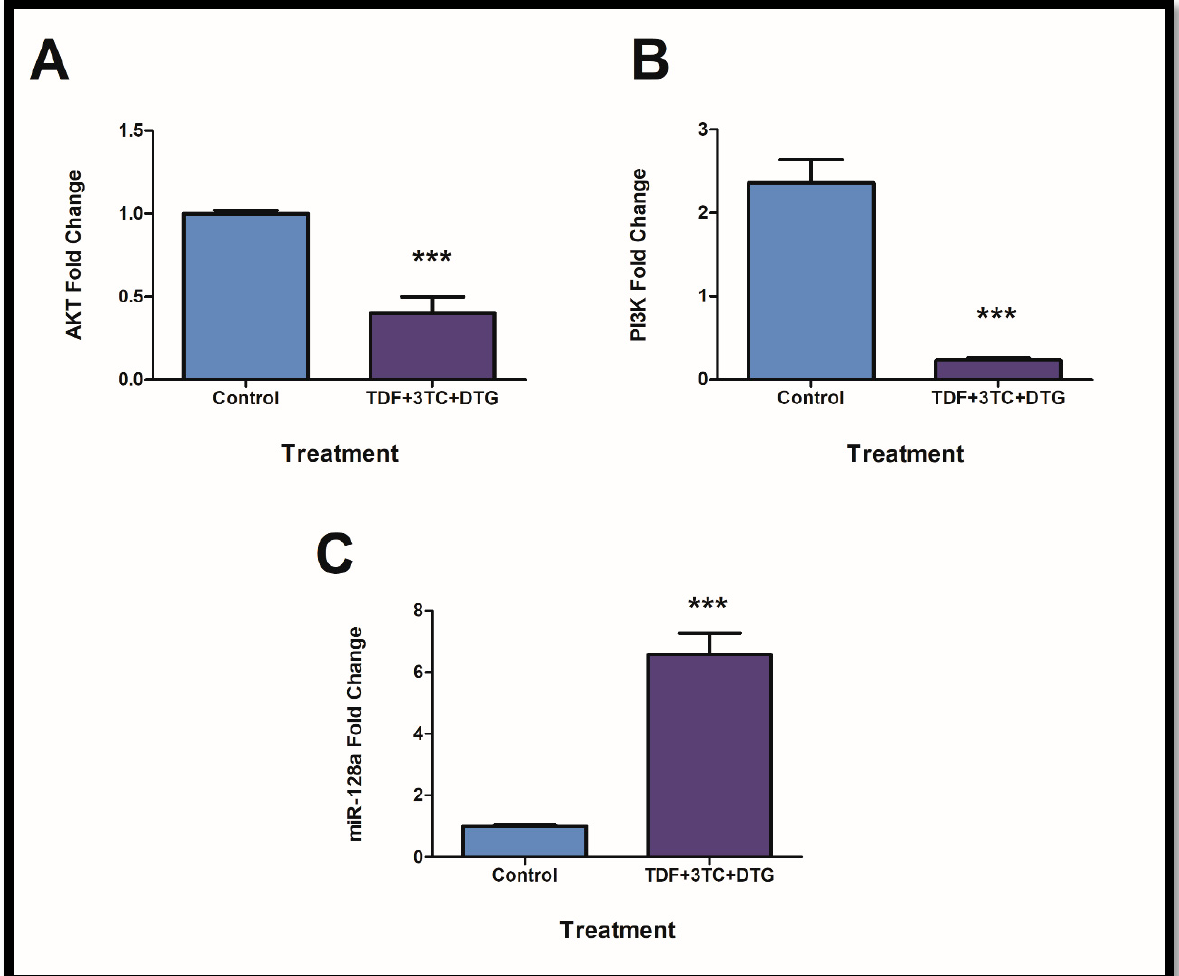
Figure 3. PI3K/AKT axis was disrupted through inflammasome activation and miRNA regulation. AKT (( A ); *** p < 0.0001) and PI3K (( B ); *** p < 0.0001) mRNA expression showed significant decreases. Conversely, miR-128a was elevated (( C ); *** p < 0.0001).